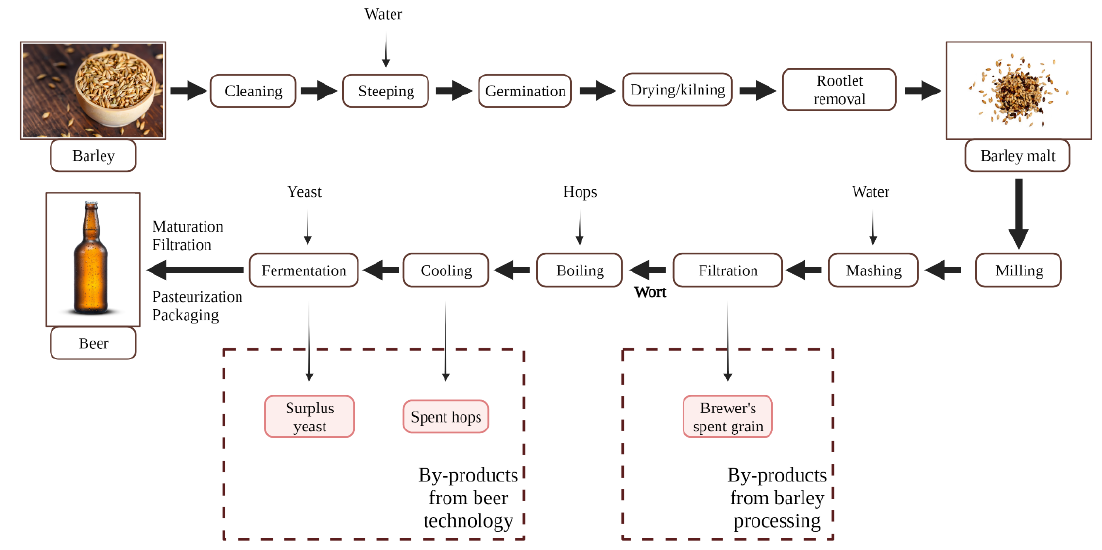
Figure 5. Types of by-products resulted after barley processing [32 –